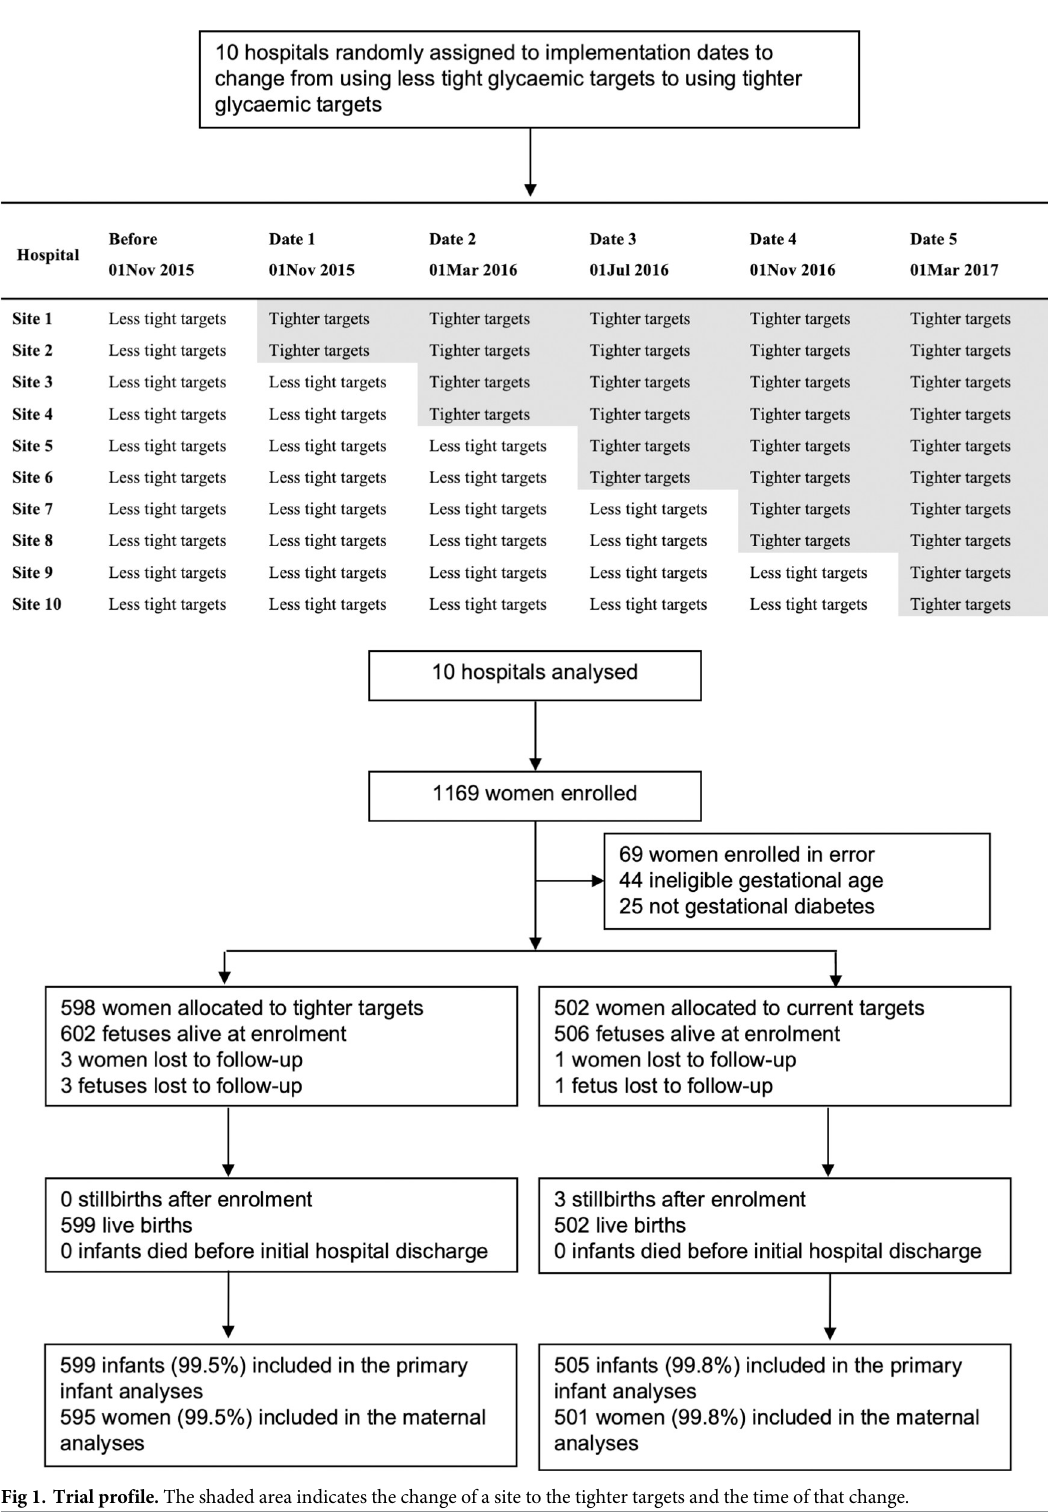
PLOS Medicine| https://doi.org/10.1371/journal.pmed.1004087 September 8, 2022 8 /